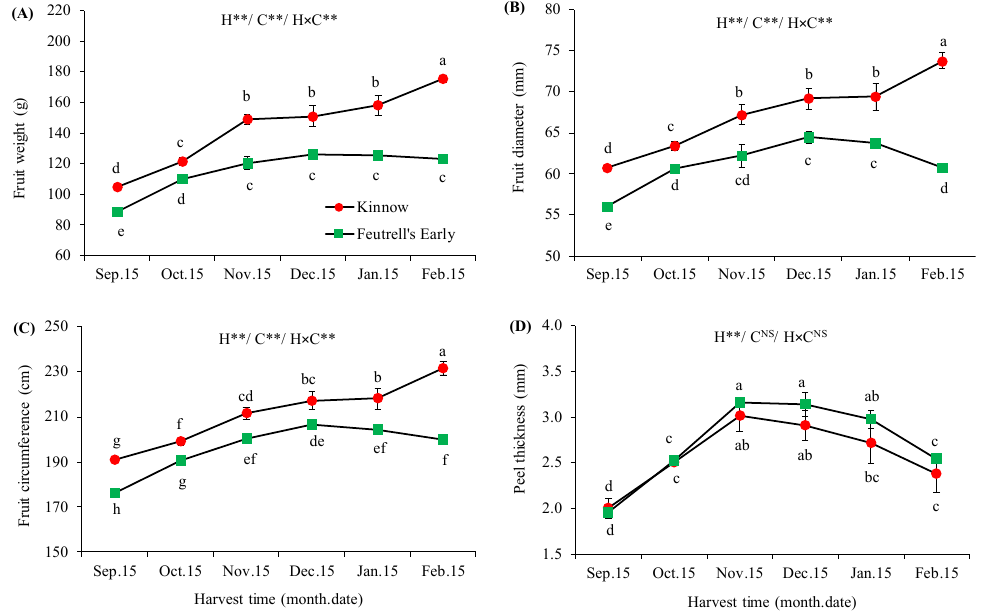
Figure 2. Changes in fruit weight ( A ), fruit diameter ( B ), circumference ( C ), and peel thickness ( D ) of mandarin fruits (Kinnow and Feutrell’s Early) at different harvest times. Error bars show standard errors of the means ( n = 4). Different lowercase letters in each graph indicate significant differences at p < 0.05 between tested samples at different stages by the least significant difference test. H and C stand for harvest time and cultivar, respectively. H × C presents the effect of the interaction of harvest time and cultivar. NS, non-significant; significant at ** p < 0.01.